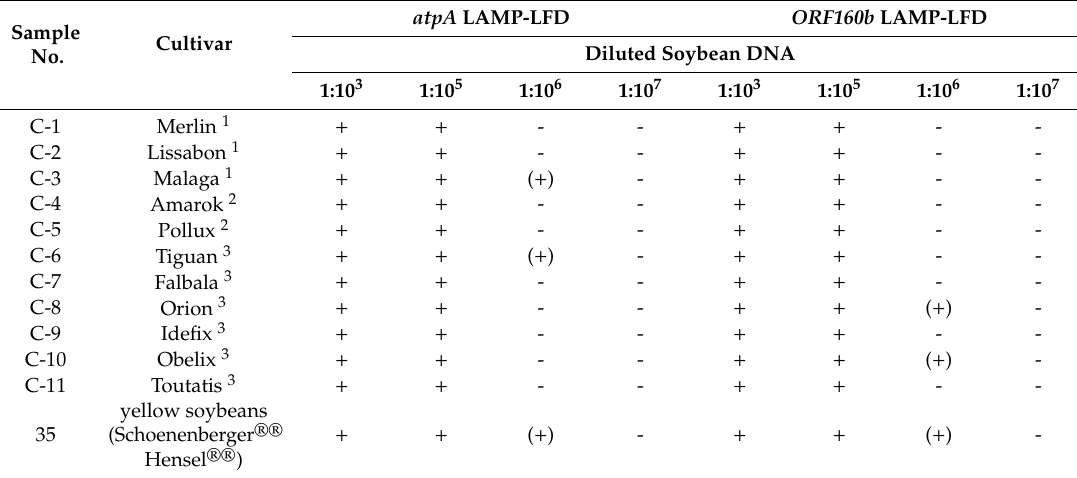
Table 2. Screening of di ff erent soybean cultivars using both LAMP-LFD assays based on diluted soybean DNA. ( + : 2 / 2 replicates positive; ( + ): 1 / 2 replicates positive; -: 2 / 2 replicates negative). Sample